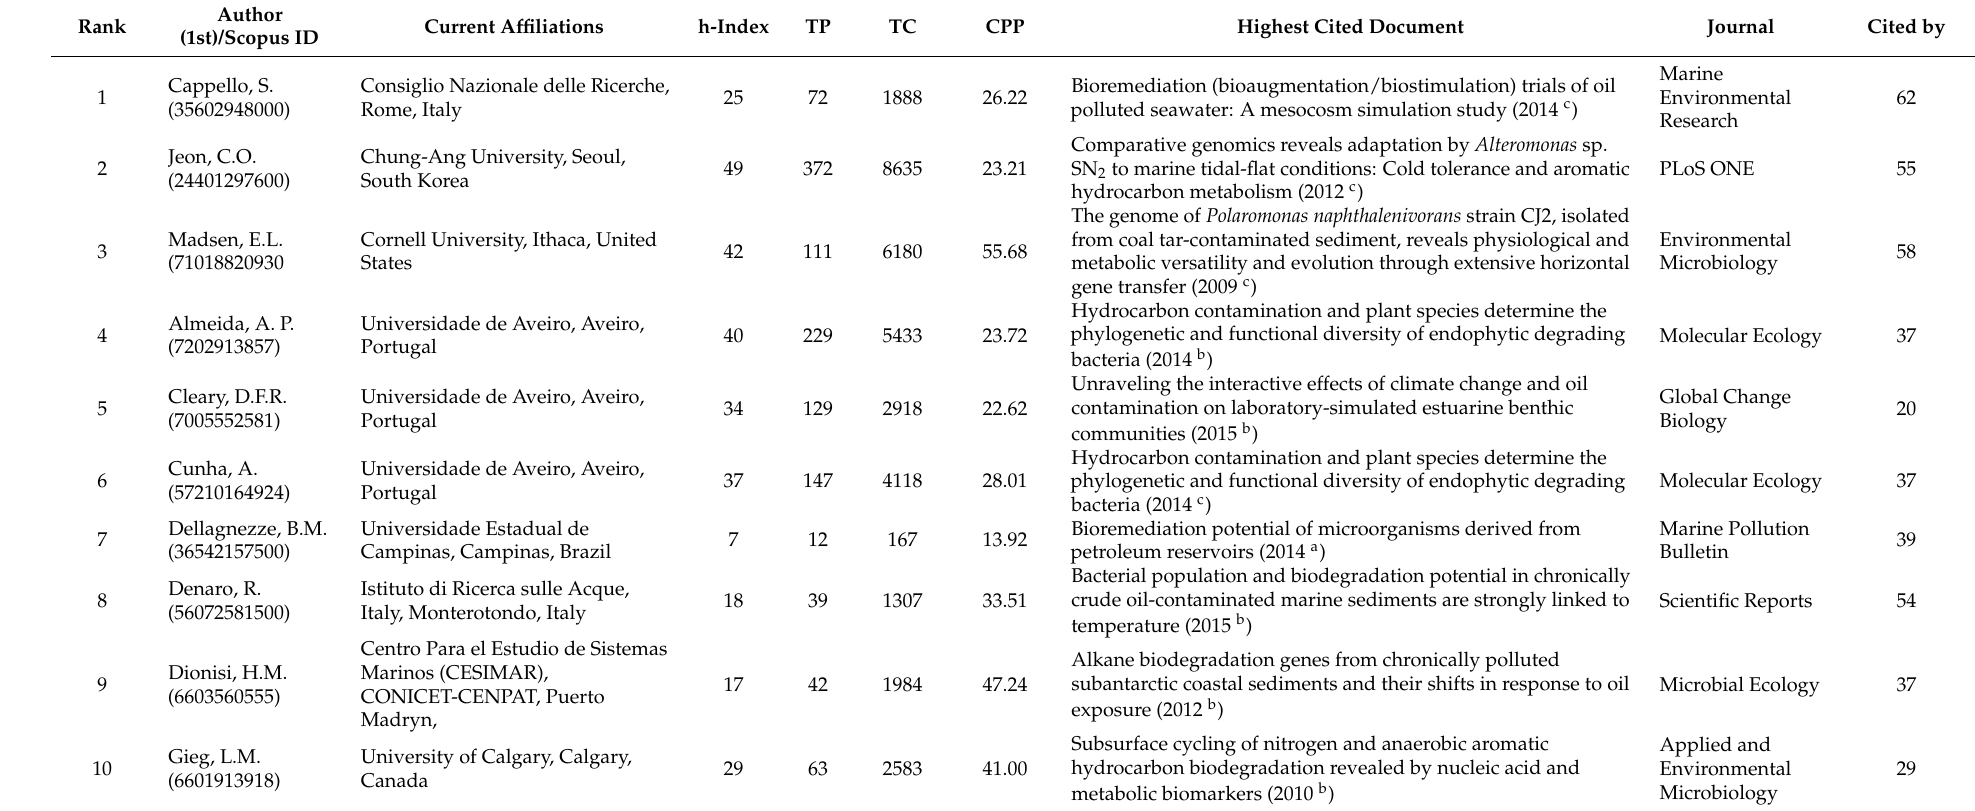
Table 5. Most productive 10 authors that published journal articles between 2009 to 2019 related to degradation of hydrocarbons in the Antarctic marine environment by microbial